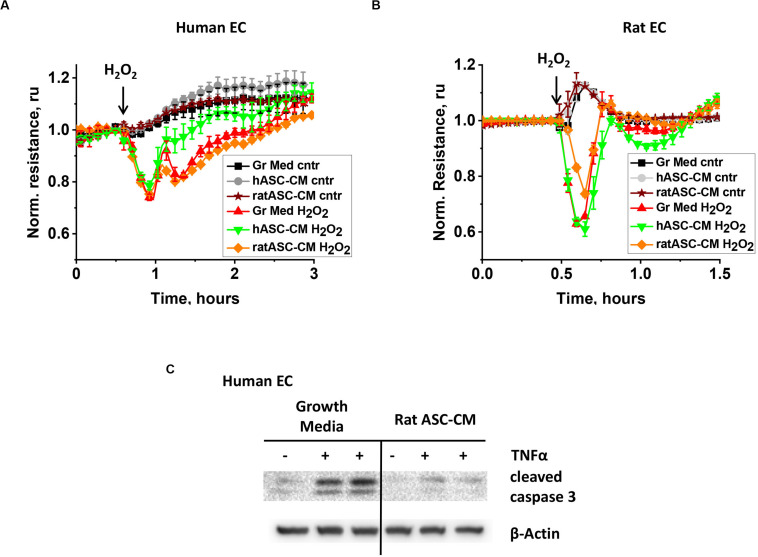
ASC-CM factors protecting from barrier dysfunction are species-specific, whereas anti-apoptotic factors are not. HPAEC (A) or RLEC (B) grown on gold electrodes of ECIS arrays were exposed to the original growth media (black, red), human ASC-CM (gray, green), or rat ASC-CM (brown, orange). Media were removed after 72 h of endothelial cell exposure, and HPAEC/RLEC were challenged with 250 μM H2O2 (red, green, orange) or vehicle (black, gray, brown). Shown are the means ± SEM of three parallel recordings. (C) HPAEC were pretreated with growth media or rat ASC-CM. After 72 h, media was substituted with EBM-2; HPAEC were challenged with 2 ng/ml TNFα for 4 h. Cell lysates were analyzed with antibodies to cleaved caspase 3 and β-actin (loading control).